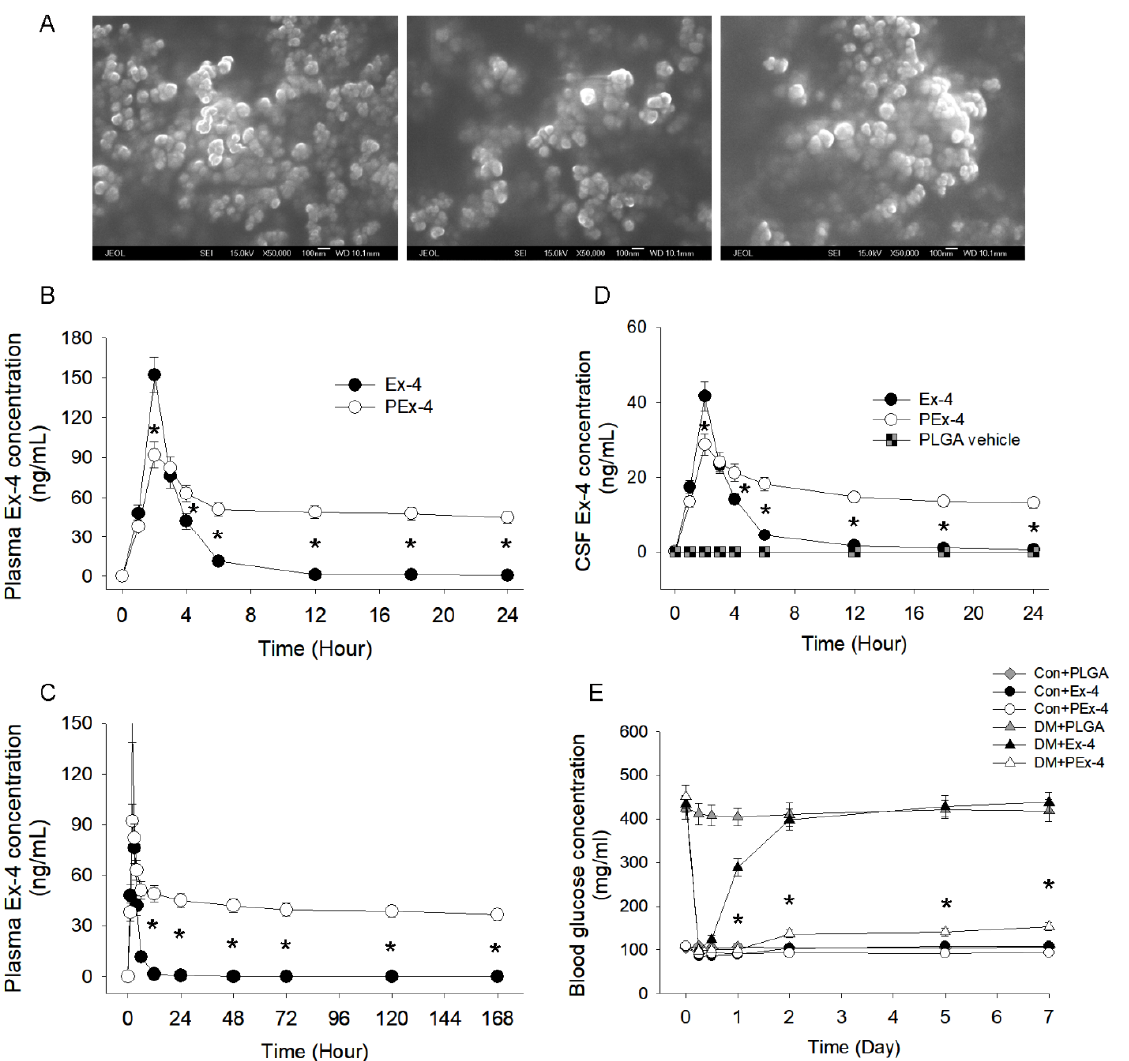
Figure 1. ( A ) Morphology and size of exendin-4 (Ex-4)-loaded